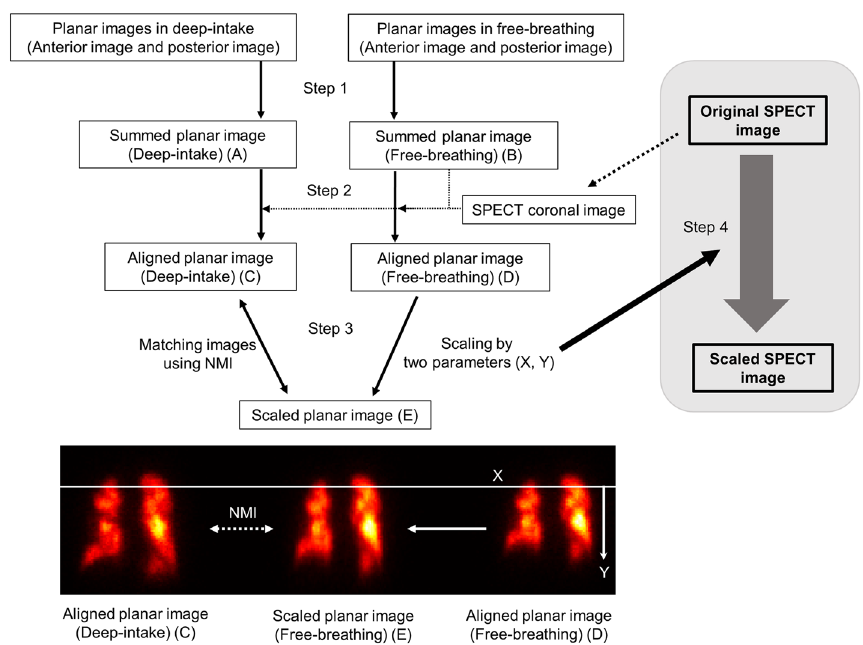
Fig. 2 Algorism of the breathing synchronization software. The scaled and co-registered SPECT image was generated from the original SPECT image and planar images using the breathing synchronization software. Abbreviations: CT computed tomography; NMI normalized mutual information; and = = SPECT single-photon emission computed =